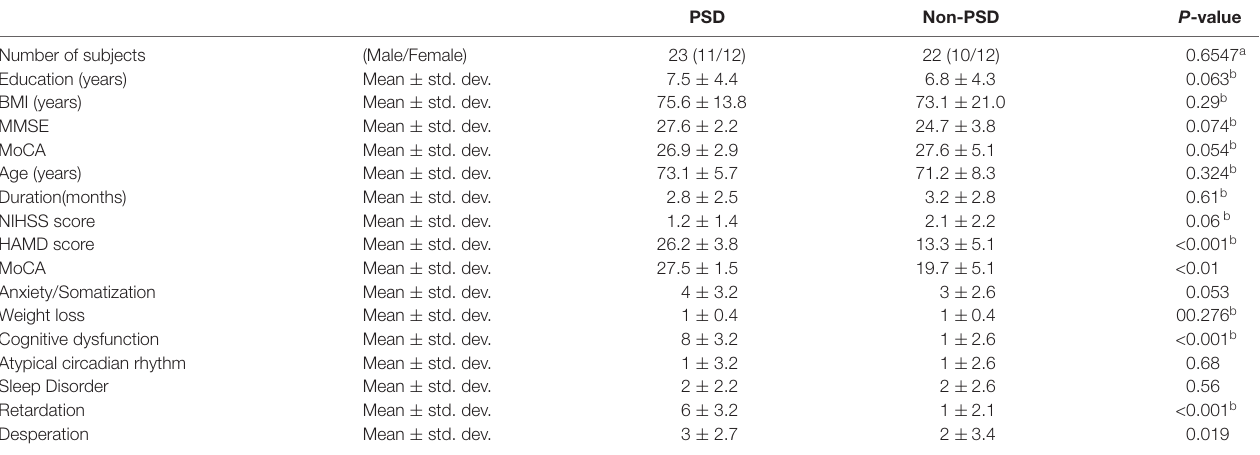
TABLE 1 | Demographic details of the recruit participants in this study.